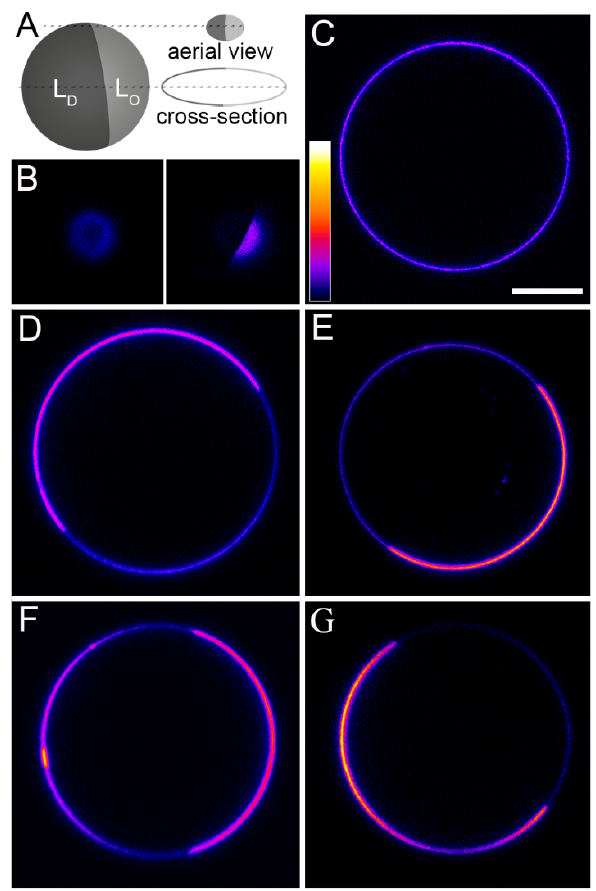
Figure 4. L o /L d -phase separated giant unilamellar vesicles (GUVs) containing different fluorescent membrane tracers. FCS measurements were performed at the top of the vesicle (see aerial view in ( A )). Only vesicles phase separation into two large domains both visible at the apex as in ( A ), side view, were analyzed. ( B ) Aerial view of GUV: BFL-SM (left image) showed no clear enrichment in either the L o or L d -phase, thus DiIC 18 (7) (right image) served as a clear marker to distinguish both phases. ( C ) Cross section of the same GUV where DiIC 18 (7) is clearly enriched in one phase (see ( B )), whereas BFL-SM is homogenously distributed. ( D ) BFL-GM1 is slightly enriched in the L d -phase, as identified by DiIC 18 (7) (not shown). ( E ) BFL-PC is also enriched in the L d -phase, as well as ( F ) TopChol. ( G ) DiIC 18 (7) is almost completely separated into the L d -phase, thus no FCS measurements could be performed in the L o -phase. Color bar represents the lowest (black—0) and the highest fluorescence intensities (white—255), fire lookup table of Fiji. Scale bar, 10 µm.